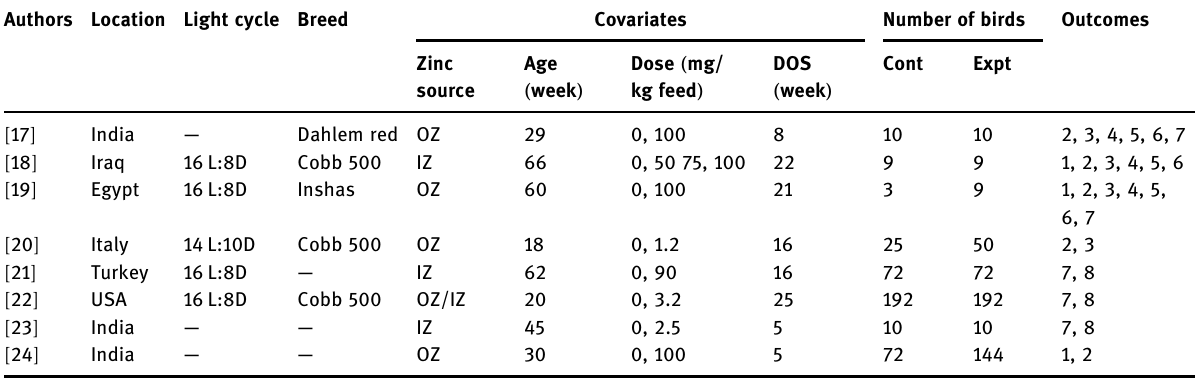
Table 1: Characteristics of studies included in the analysis Authors Location Light cycle Breed Covariates Number of birds